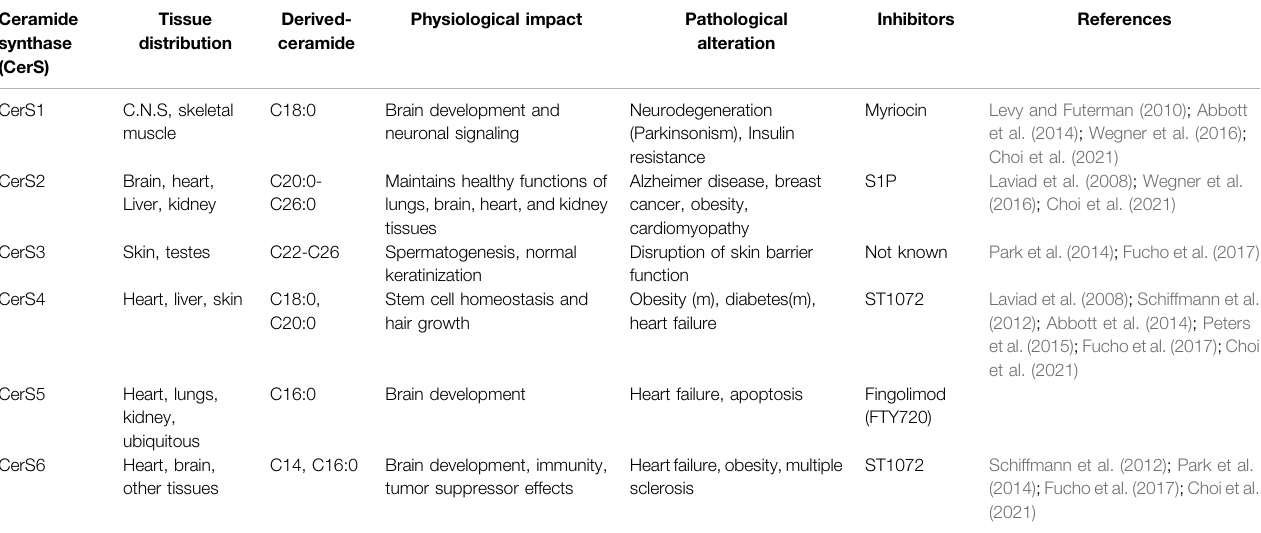
TABLE 1 | Ceramide synthases tissue distribution and their inhibitors as therapeutic